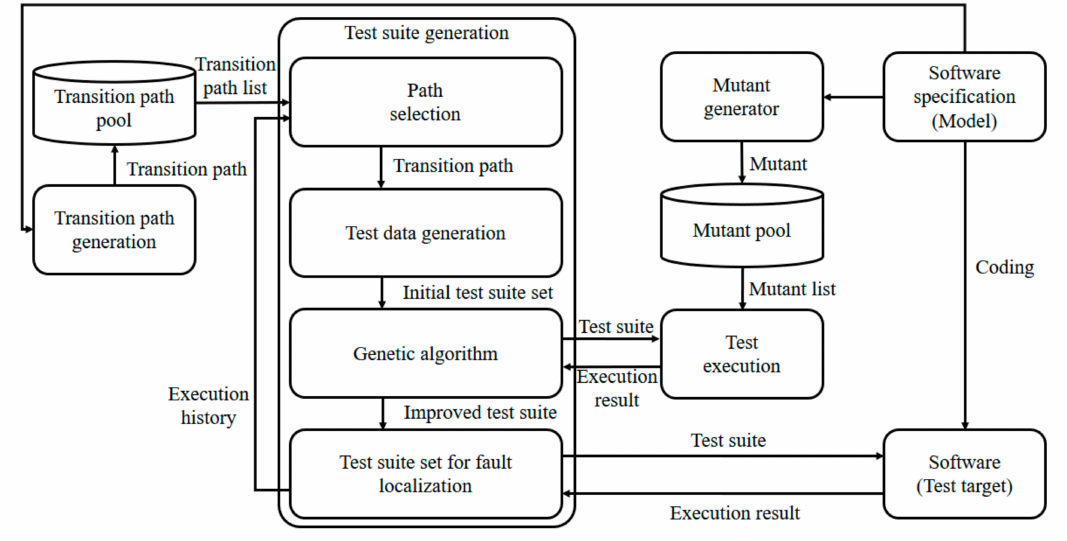
Figure 2. Framework of the proposed